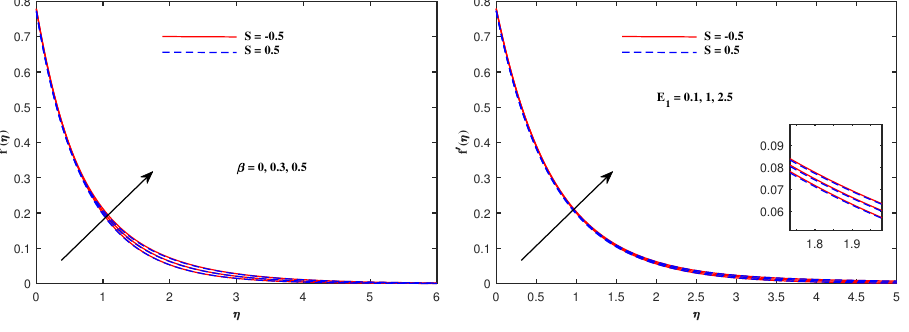
Figure 2. Velocity variation with β and E 1 .